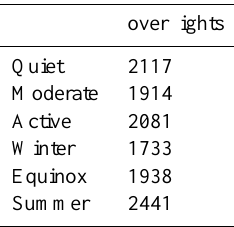
Fig. 10. Distribution of data points ( top, left ) for the 6112 1D overflights as a function of magnetic latitude and MLT. Here, one data point refers to one measurement in the 1 Hz CHAMP data, with the total number of points 2195327. j r ( top, right: field-aligned component, positive up), J θ ( bottom, left: north-south component, positive south) and J φ ( bottom, right: east-west component, positive east) as a function of MLT and magnetic latitude. The number of data points or the magnitude and direction of the current density in each cell is given according to the color bar on the right hand side of the plot. Resolution of the plots is 0 . 5 h in MLT and 1 ◦ in latitude. On the top of the figure is written the total number of overpasses used to construct the set of four plots.